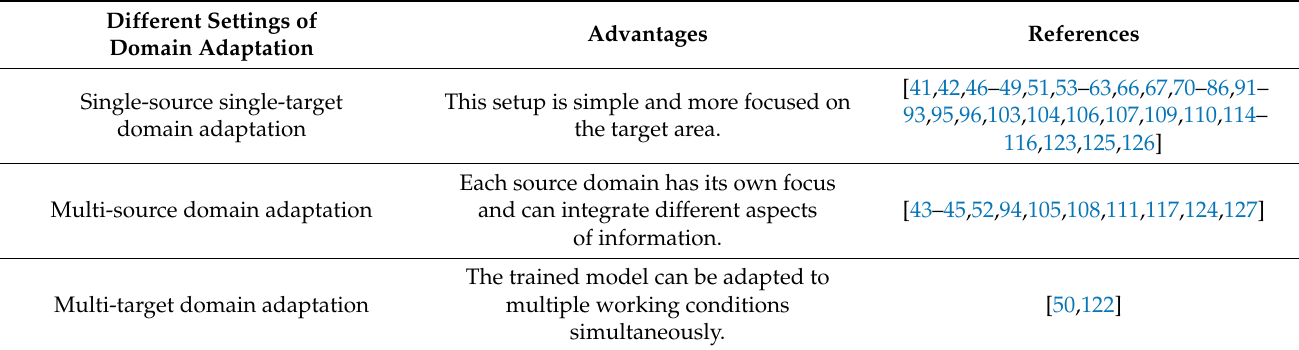
Table 3. Classification results based on the number of source and target